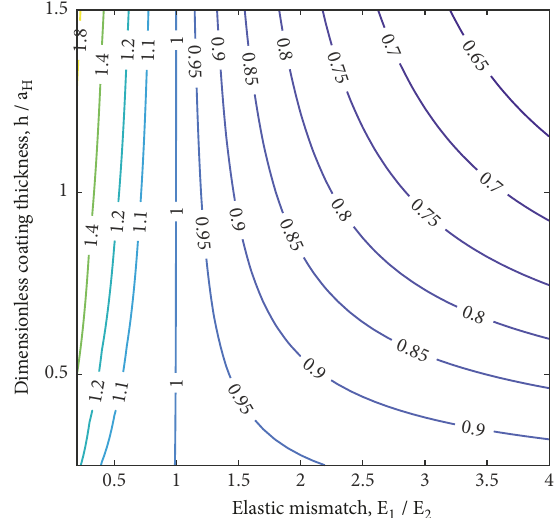
Figure 9: Iso-contours of dimensionless rigid-body approach 𝛿/𝛿 𝐻 .